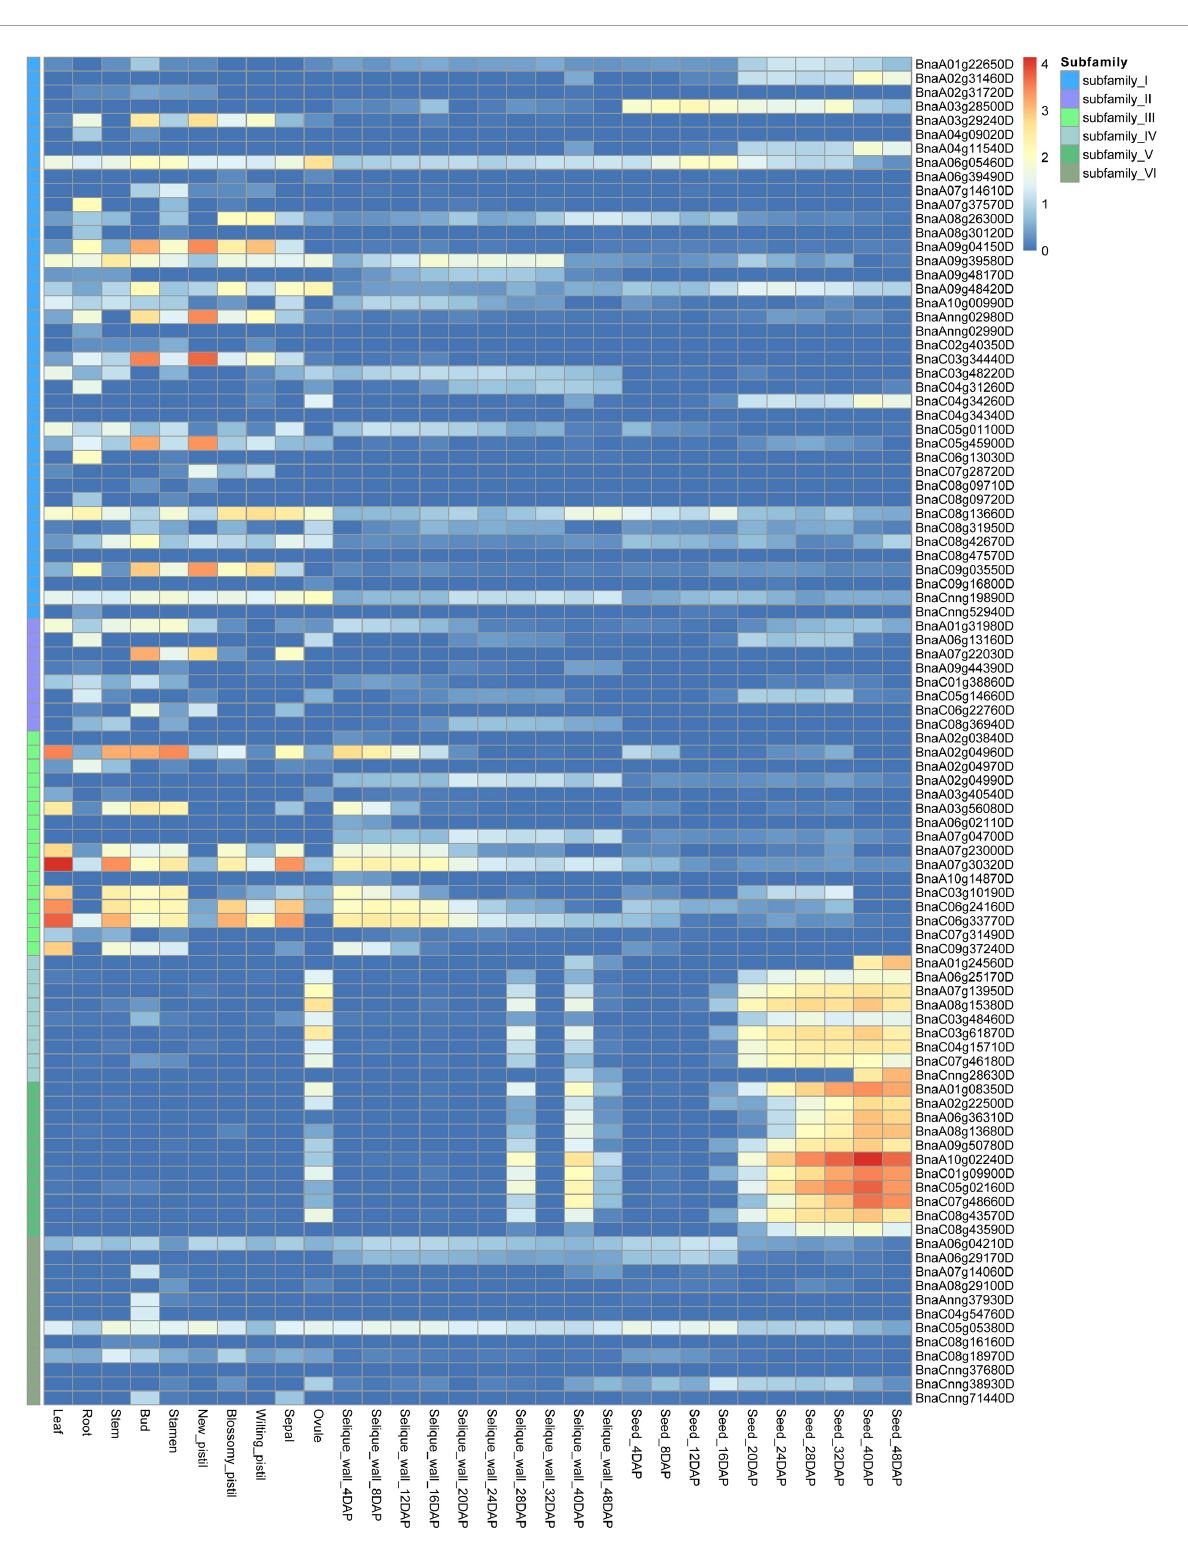
FIGURE5 Expression patterns of 96 BnCDP genes in 30 tissues of Brassica napus ZS11 variety. The expression data were processed with the log 10 normalization of fragments per kilobase million (FPKM). The color scale represents relative expression levels from low (blue color) to high (red